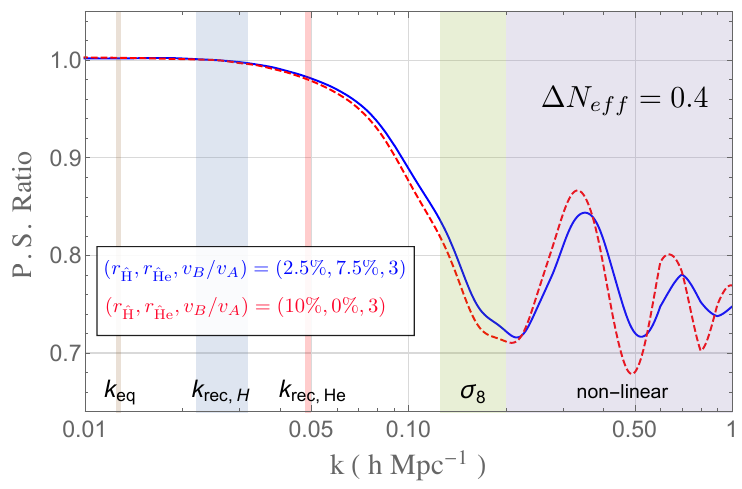
Figure 6 . Ratio of the matter power spectra between (cid:3)CDM+MTH and (cid:3)CDM+DR. Results are shown for two di(cid:11)erent abundances of mirror H and He, but for the same value of v B =v A . The blue curve considers r all = 0 : 1 with Y ^He = 0 : 75, which is close to the value from the full MTH scenario studied in section 2.2. The red dashed curve corresponds to the hydrogen-only scenario, again with r all = 0 : 1. The two curves begin to exhibit percent level di(cid:11)erences for k > However, since the blue and red curves correspond to the same r all for the blue and red curves the average suppression for large k -modes is the same, as discussed in eq. (3.15).